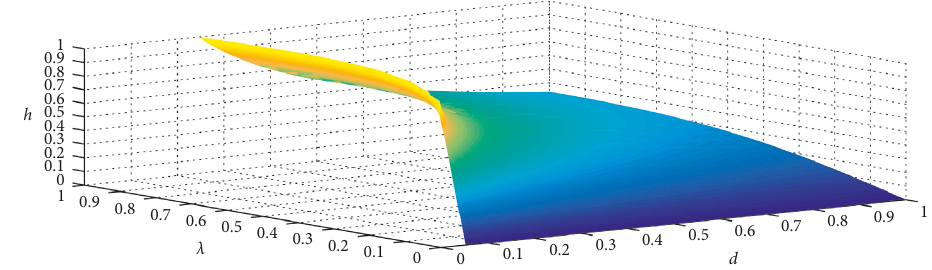
Figure 4: Developer’s moral hazard behavior level h